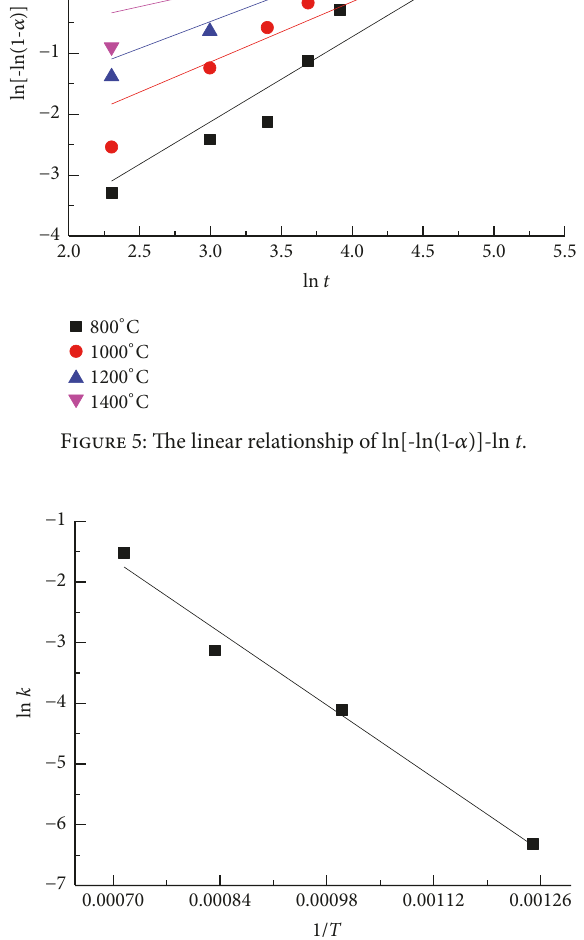
Figure 6: The linear relationship of ln k -1/ T